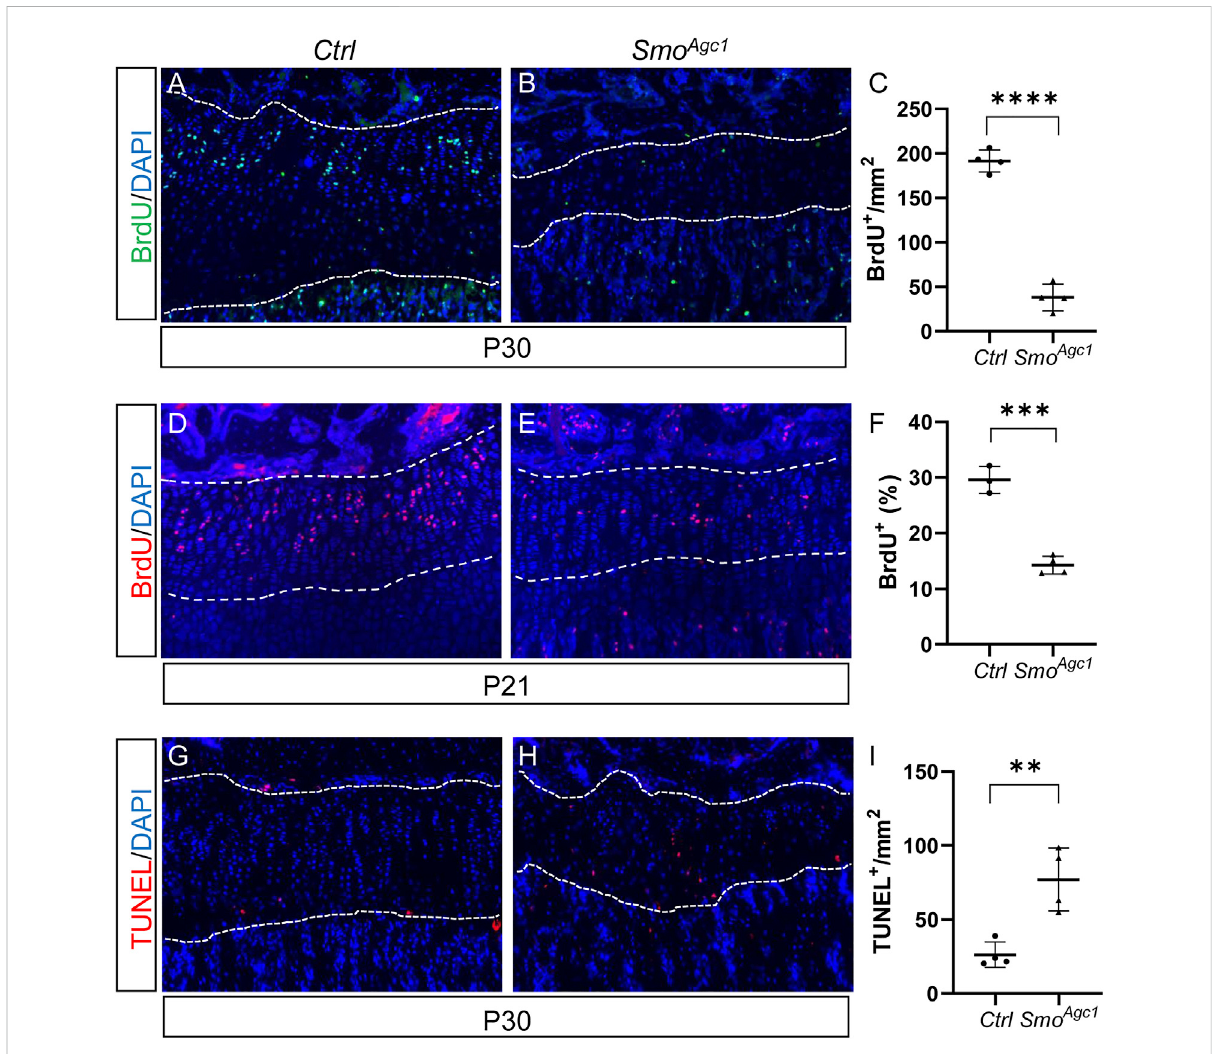
FIGURE 3 Chondrocyte-speci fi c deletion of Smo in juvenile mice led to reduced chondrocyte proliferation and increased chondrocyte apoptosis (A,B) BrdUstainingofproximaltibialgrowthplatesfromP30 Ctrl (A) and Smo Agc1 mice (B) .BrdU-labeledcellswereshowningreenandnucleiwerestained in blue (C) Quanti fi cation of BrdU-positive cells normalized to areas of proximal tibial growth plates in P30 Ctrl and Smo Agc1 mice (D,E) BrdU staining of proximal tibial growth platesfrom P21 Ctrl (D) and Smo Agc1 mice (E) . BrdU-labeled cells wereshown in red and nuclei were stained in blue (F) Quanti fi cation of the percentage of BrdU-positive cells in columnar zones of proximal tibial growth plates from P21 Ctrl and Smo Agc1 mice (G,H) TUNEL assay of proximal tibial growth plates from P30 Ctrl (G) and Smo Agc1 mice (H) . Apoptotic cells were shown in red and nuclei